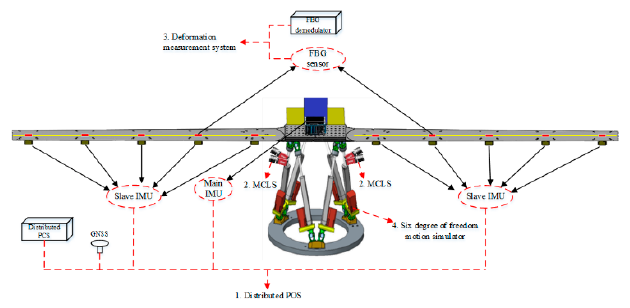
Figure 9. Overall composition diagram of the system.